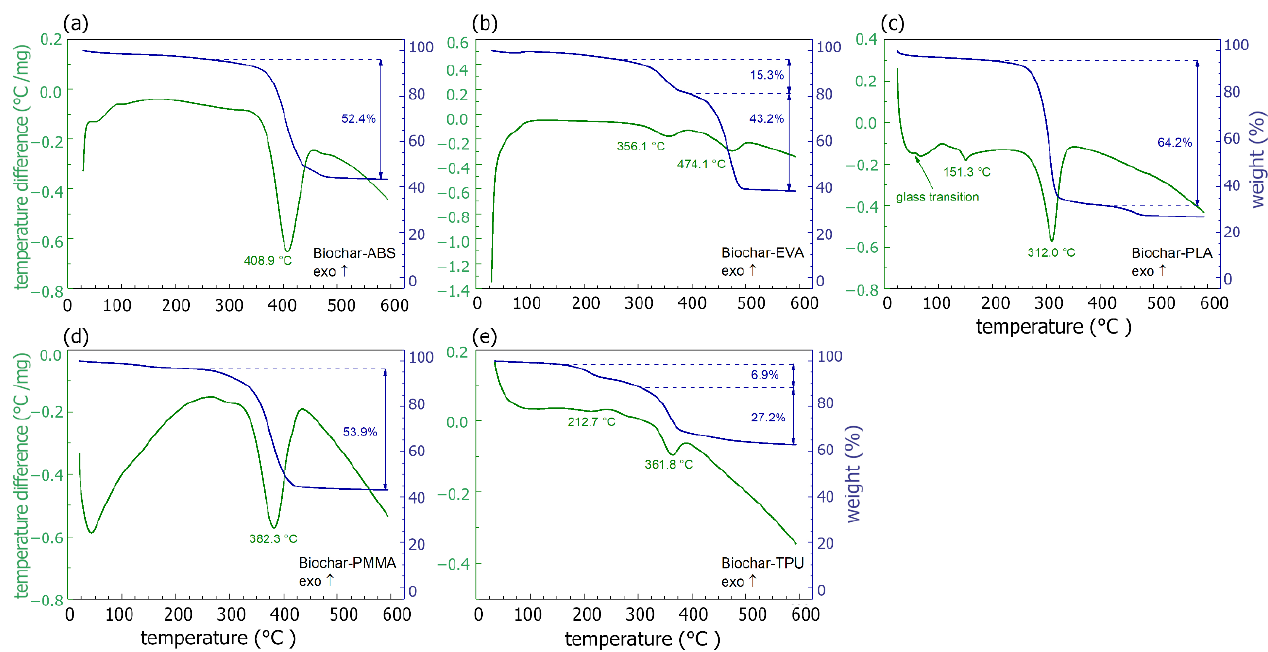
Figure 3. DTA (green lines) and TGA (blue lines) measured for biochar composites: ( a ) ABS-biochar, ( b ) EVA-biochar, ( c ) PLA-biochar, ( d ) PMMA-biochar, and ( e ) TPU-biochar (60 wt.% In the range of low temperatures, below 100 °C, changes in DTA signals were ob- served, related to a slight decrease (a few %) in mass, suggesting that evaporation of